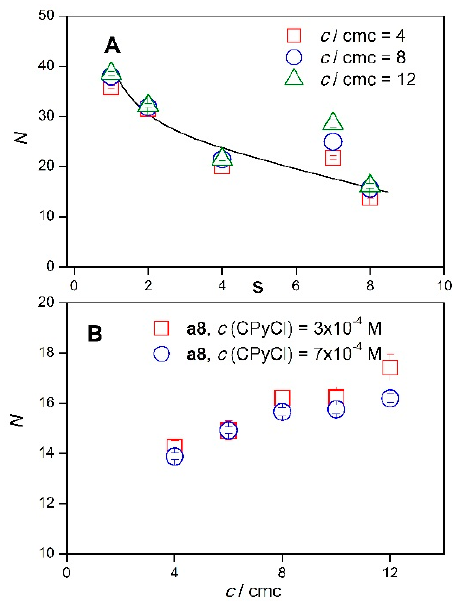
Figure 2. A: Micelle aggregation number N of a(s) surfactants plotted as a function of spacer number s